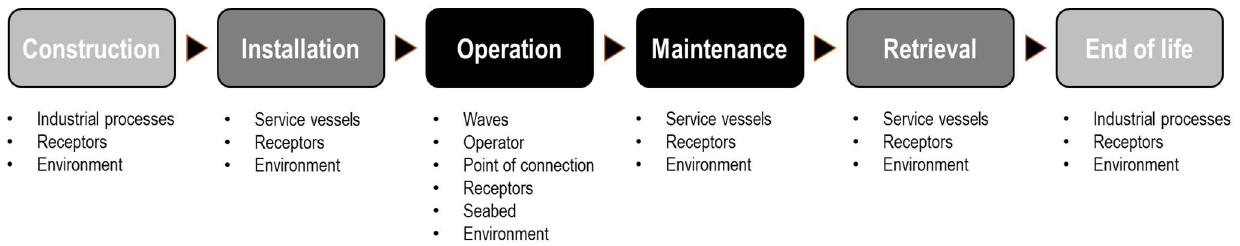
Figure 7. Lifecycle of the wave energy system and entities.